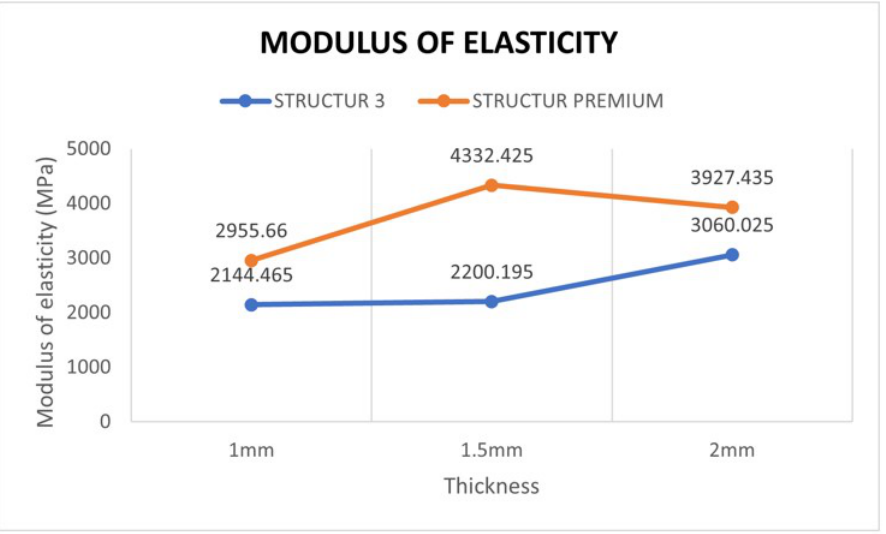
Figure 4. Modulus of elasticity obtained in both materials and comparison between different thick- ness (median).